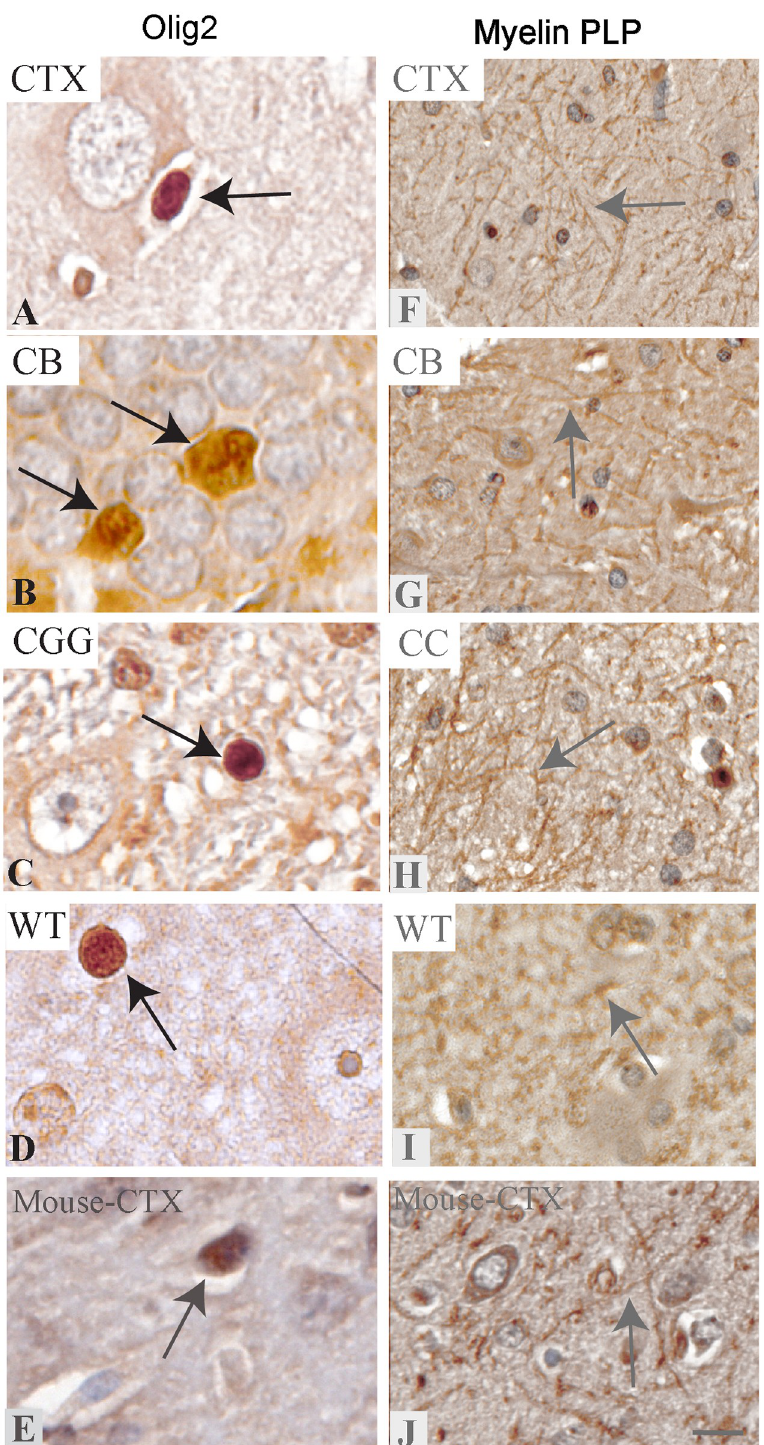
Fig 3. Immunolabeling of mature oligodendrocyte lineage markers in the NF1 mutant and wild-type miniswine brain. Brain regions are identified as cortex (CTX), cerebellum (CB), cerebral aqueduct (CGG) and corpus callosum (CC). A-D: Olig2+ expression in the cortex, cerebellum, cerebral aqueduct, and thalamus in wild-type, localized to the nucleus and cytoplasm of oligodendrocytes. Arrows indicate mature oligodendrocytes. E: Olig2+ expression in mouse cerebral cortex. F-I: Myelin PLP+ expression in the cortex, cerebellum, corpus callosum, and thalamus in wild-type